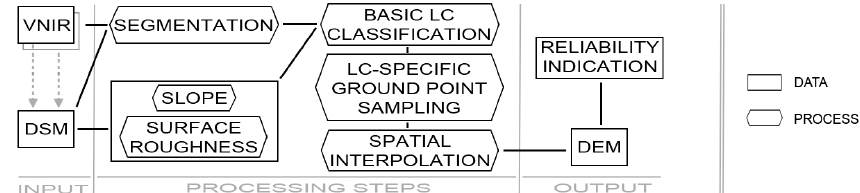
Figure 2. Graphical overview of the workflow based on land cover (LC) stratification and ground point (GP) sampling conducted in the proposed approach. DSM: digital surface model; DEM: digital elevation model; VNIR: visible red-green-blue and near infrared spectral